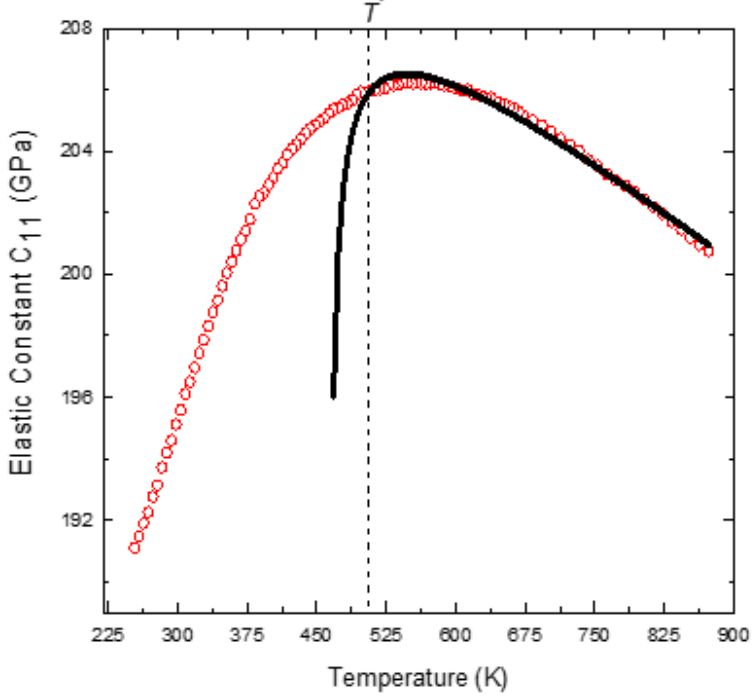
Figure 3. Fit of the experimental C 11 (open circles) with Equation (6) (solid line) of PMT (Reprinted with kind permission from Ref. [41]. 2015, the European Physical Journal (EPJ)).